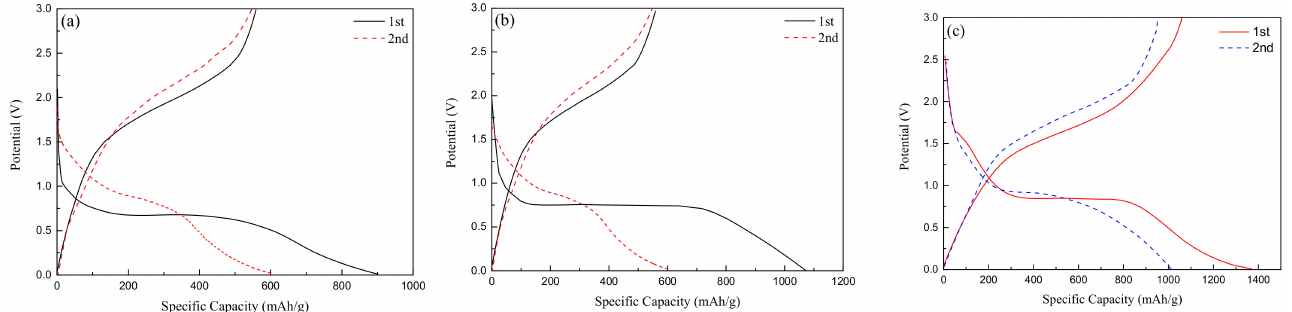
Figure 6. Charge-discharge curves of ( a ) Fe 2 O 3 -175 ◦ C; ( b ) Fe 2 O 3 -220 ◦ C; ( c ) 0.2rGO/Fe 2 O 3 -175 ◦